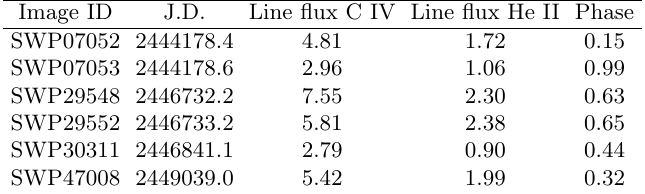
Table 7. Line (cid:13)uxes of AN UMa from the IUE spectra. (The integrated (cid:13)uxes are units of 10 (cid:0) 13 erg cm (cid:0) 2 s (cid:0) 1 . Image ID